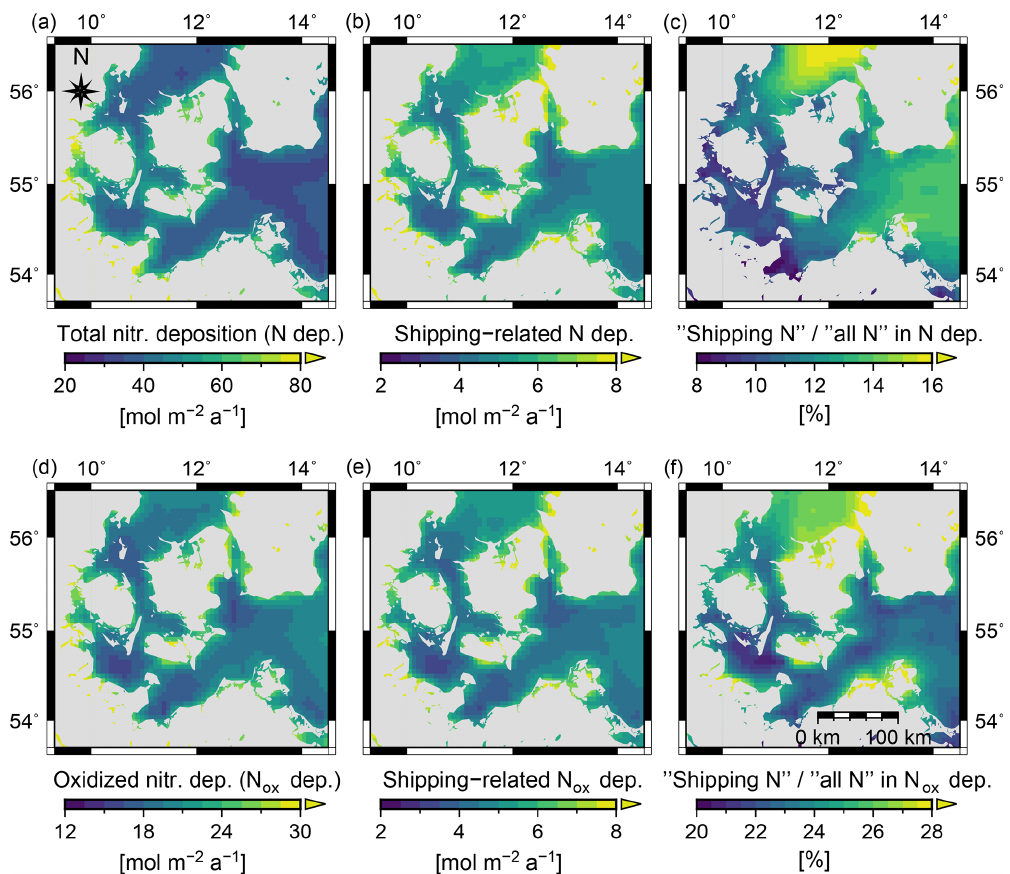
Figure 2. Annual mean deposition of total nitrogen (TN, a–c ) and oxidized nitrogen (NO X , d–f ) calculated by the CMAQ model. The nitrogen deposition (nitrogen from all sources, a , d ), the shipping-related nitrogen deposition (b, e) , and the quotient between the two (c, f) are